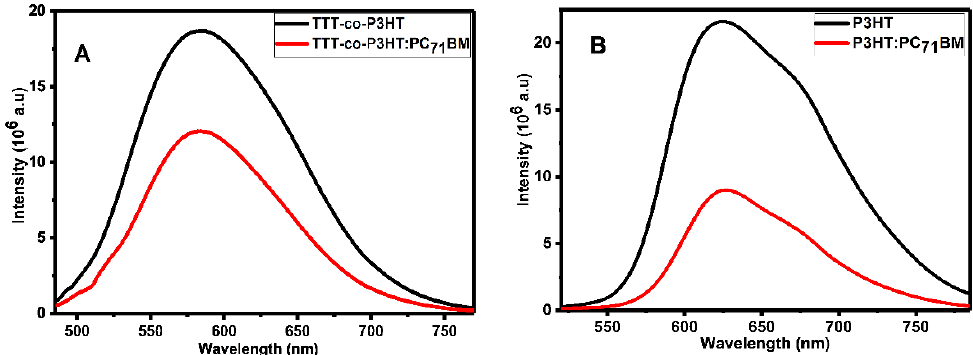
Figure 4. Photoluminescence spectra of ( A ) TTT-co-P3HT and TTT-co-P3HT:PC 71 BM and ( B ) P3HT and P3HT:PC 71 BM.